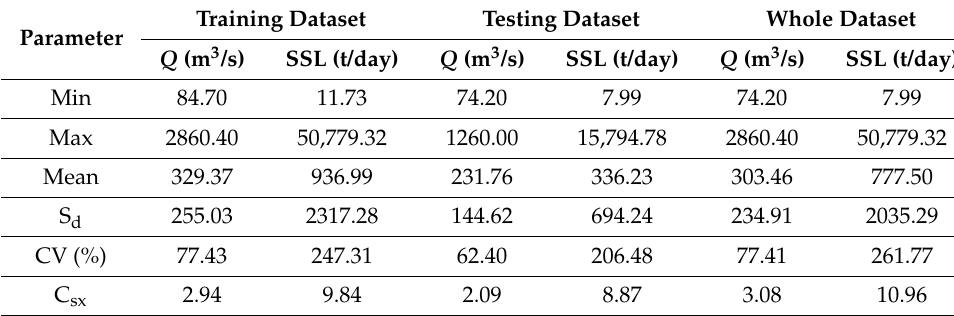
Table 1. Statistical analysis of the Pirna gauging station datasets.